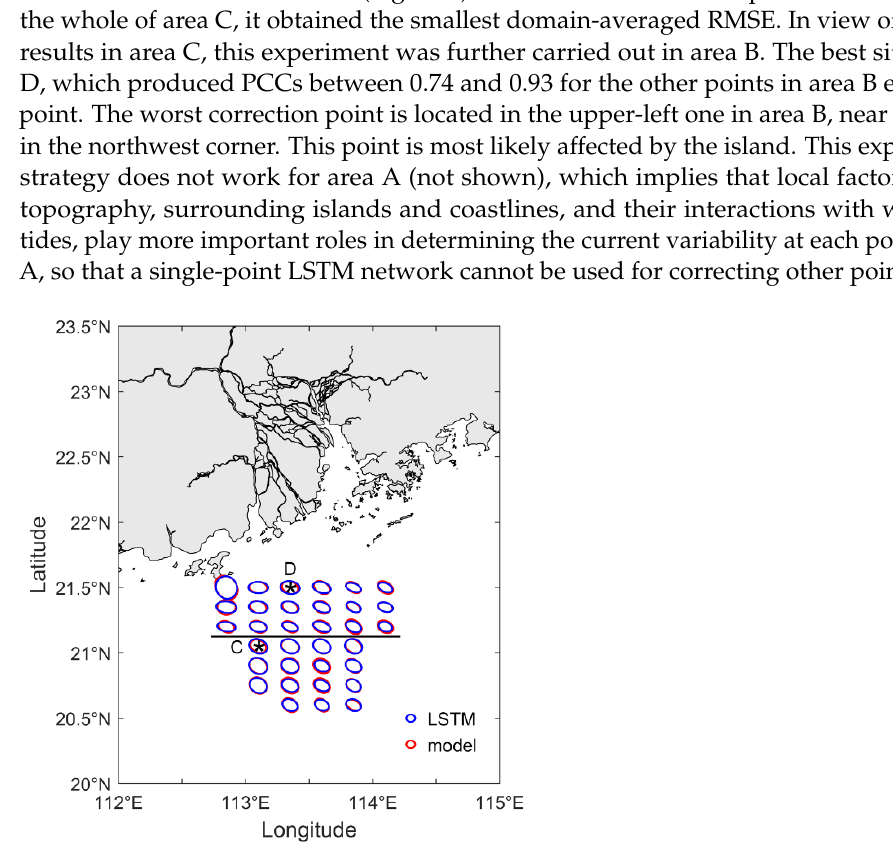
Figure 6. EOF ellipses calculated from LSTM validation results (blue) and model (red) in area B and area C (marked in Figure 2b), which are separated by a solid black line. The whole area C was corrected by the LSTM network trained by point C and area B was corrected by the LSTM network trained by point D. Point C (113.1°E, 21.05°N) and point D (113.35°E, 21.5°N) are marked with “ * ”.